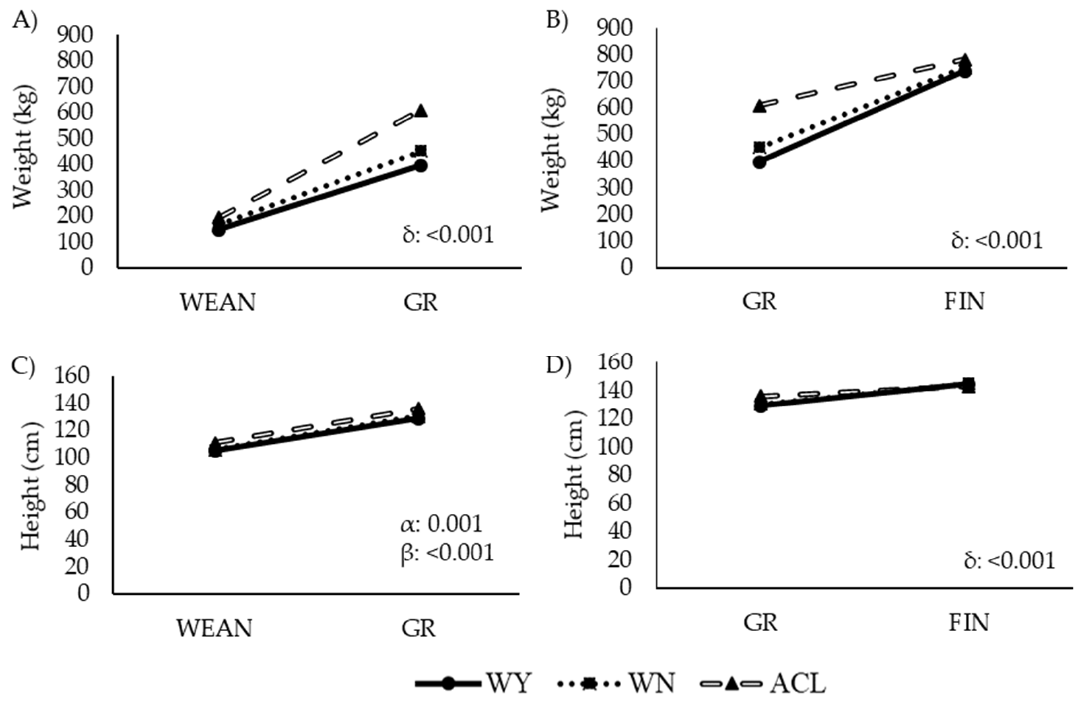
Figure 3. Changes in ( A , B ) weight and ( C , D ) height of steers during two intervals within the fattening period. Abbreviations: ACL: crossbred animals Angus-by-Charolais or Angus-by-Limousin; WEAN to GR: weaning to growing interval; GR to FIN: growing to finishing interval; WN: Wangus animals (Wagyu-by-Angus) breed; WY: fullblood Wagyu animals. α indicates significant effect by breed; β indicates significant effect by time; δ indicates significant effect by the interaction between breed and time. Parameters are expressed as median values.